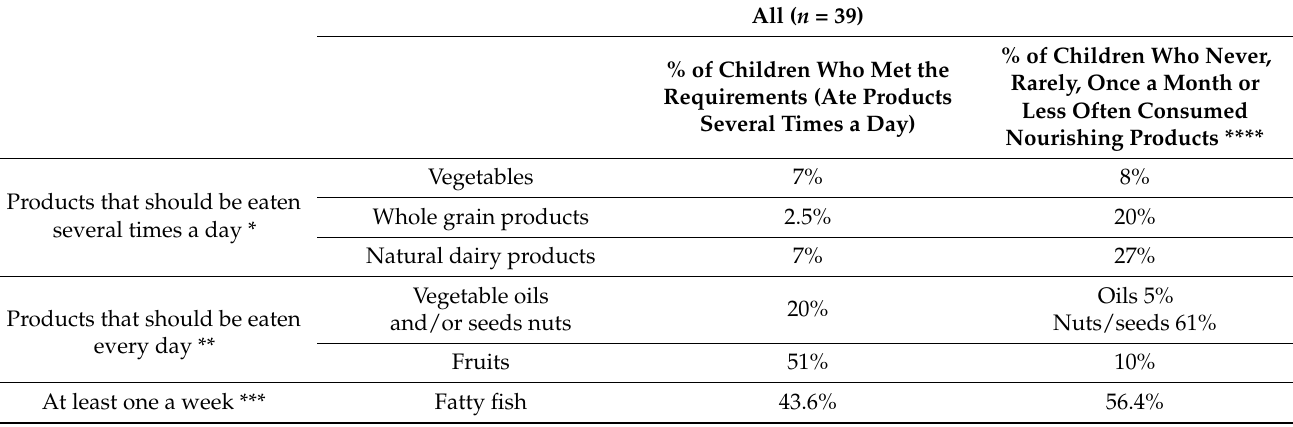
Table 6. The food consumption by children with Down syndrome concerning the